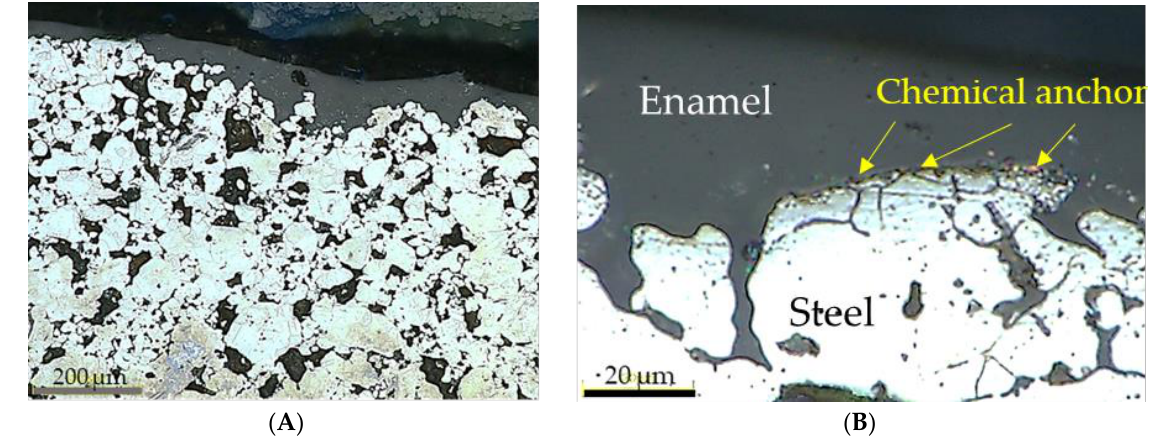
Figure 13. Optical micrographs of sample sintered and enameled in one step at 835 °C: ( A ) general overview, ( B ) detail of edge with the enamel after surface attack with 3 v/v% nital (mixture of nitric acid and ethanol).